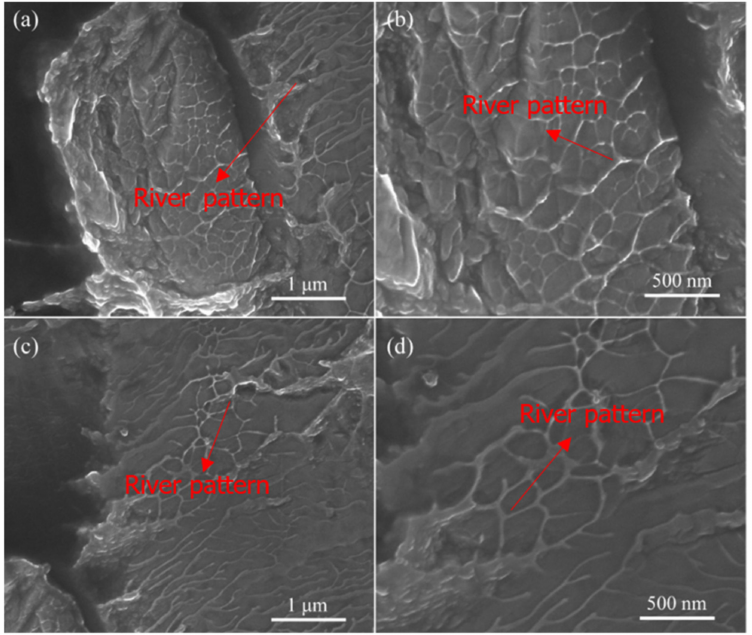
Figure 5. SEM images showing fracture of the magnesium-based amorphous alloy